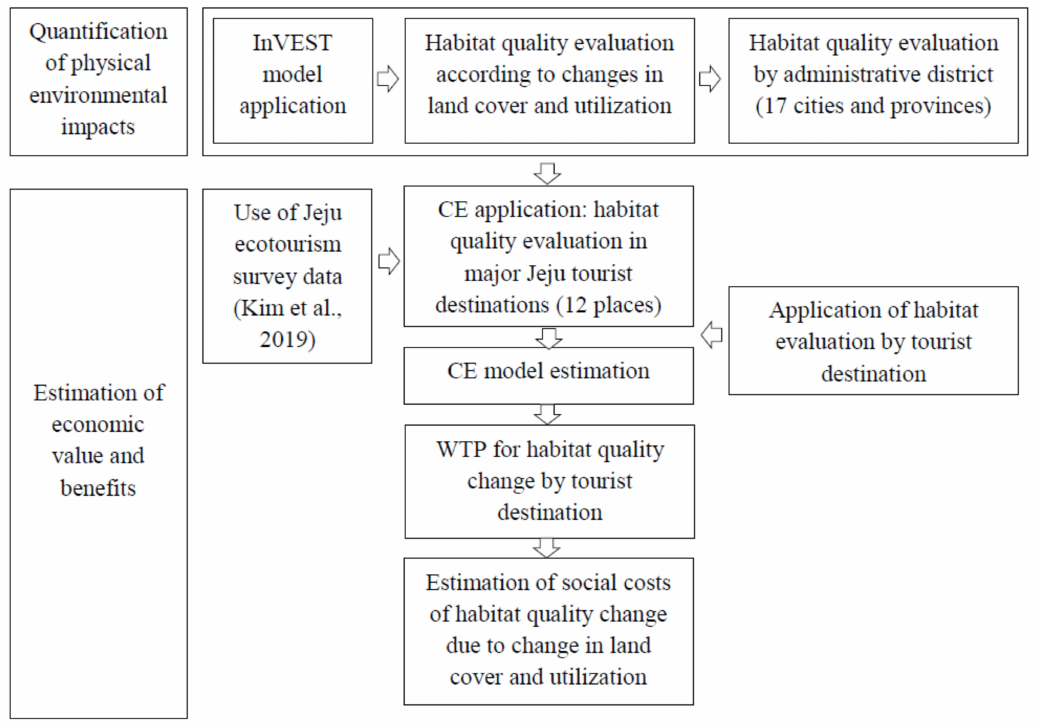
Figure 1. Illustration of Integrated Environmental and Economic Analysis to estimate the economic value and benefits of changes in ecosystem habitat